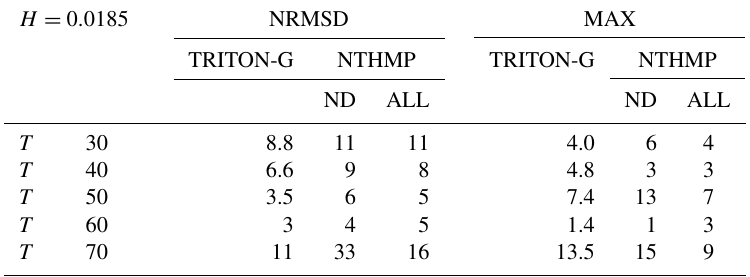
Table A1. Modeled surface profile errors with respect to laboratory experiments for case A H/d = 0 . 0185 at times 30, 40, 50, 60, and 70. Results from the NTHMP workshop errors are separated in non-dispersive (ND) models and all models (ALL).